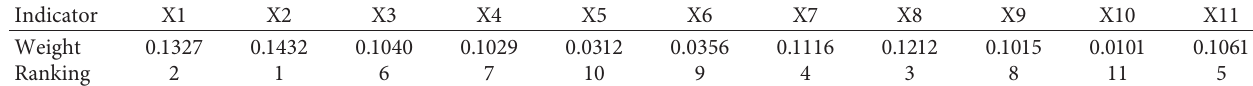
Table 4: Weights and rankings of all risk